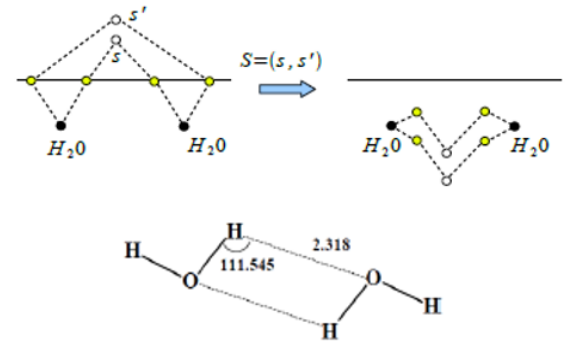
Fig. 6. Modeling of water dimer isomers by